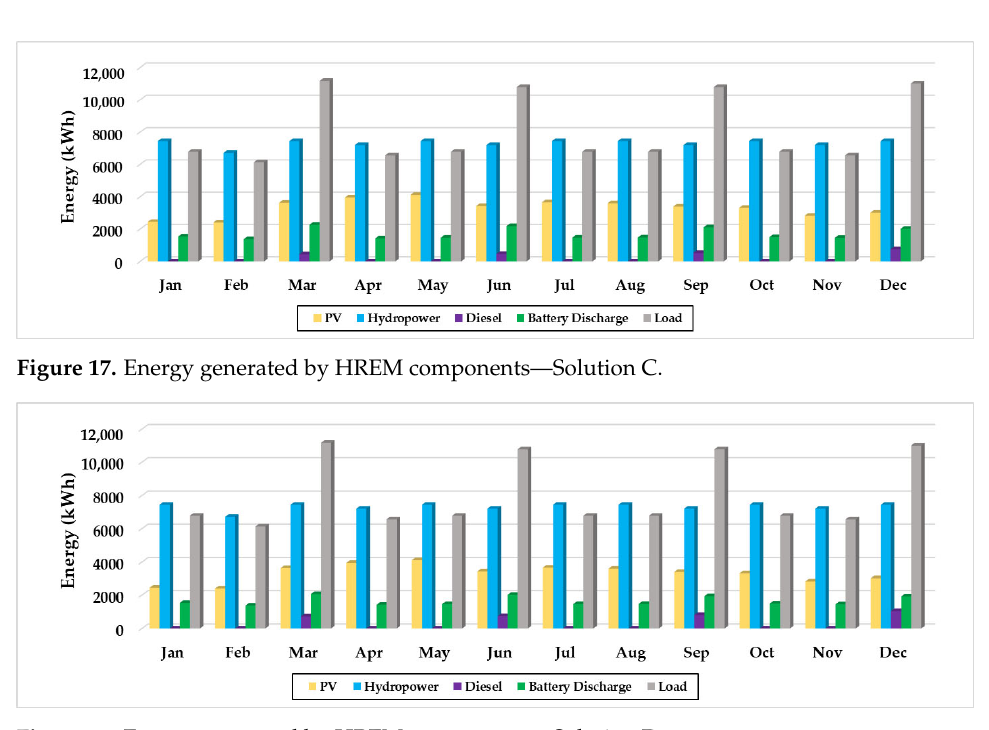
Figure 18. Energy generated by HREM components—Solution